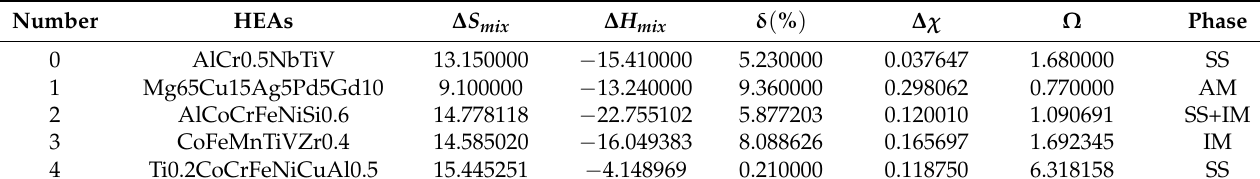
Table 2. Pandas snapshot of the first six samples.